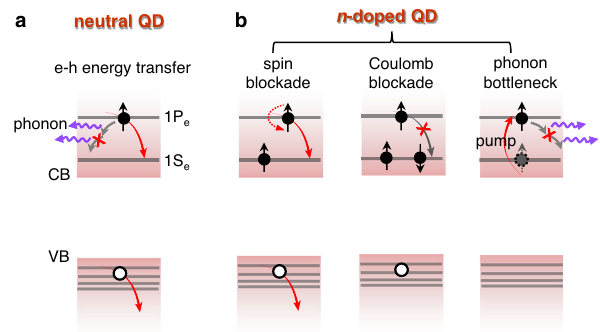
Fig. 1 Slow hot electron relaxation in n -doped QDs. a In a typical CdSe QD, an 1P e hot electron relaxes on a sub-ps timescale through electron-to-hole energy transfer, breaking the otherwise expected phonon bottleneck. b In n - doped QDs, slow hot electron relaxation is expected due to the preoccupying 1S e electrons. For a QD doped with one 1S e electron (left), there is a 50% probability that the 1P e electron would relax slowly due to a Pauli spin blockade; for a QD doped with two 1S e electrons (middle), relaxation of the 1P e electron is completely blocked due to state- fi lling; alternatively, a preoccupying 1S e electron can be excited into the 1P e level (right), which would be followed by slow relaxation because the phonon bottleneck cannot be bypassed for lack of a valence band